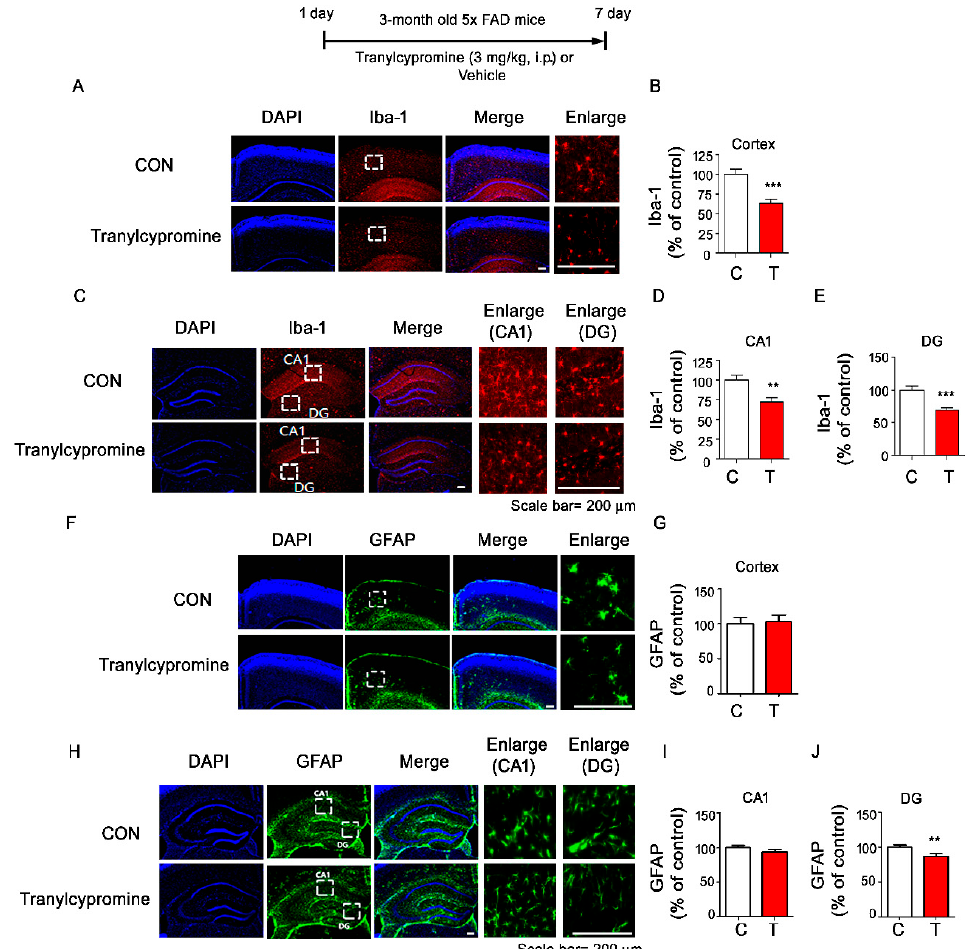
Figure 7. Tranylcypromine alters A β -induced microgliosis in a mouse model of AD. ( A , C , F , H ) 5xFAD mice were injected with tranylcypromine (3 mg / kg, i.p.) or PBS daily for 7 days, and immunohistochemistry was performed with anti-Iba-1 and anti-GFAP antibodies. ( B , D , E ) Quantification of data from ( A ) (cortex: n = 5 mice / group) and ( C ) (CA1 and DG: n = 5 mice / group). ( G , I , J ) Quantification of data from ( F ) (cortex: n = 5 mice / group) and ( H ) (CA1 and DG: n = 5 mice / group) ** p < 0.01, *** p < 0.001. CON and C, control; T, Tranylcypromine.